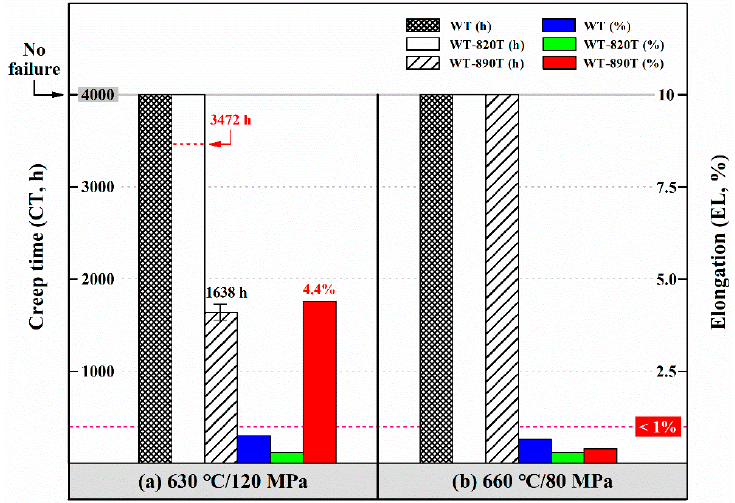
Figure 6. Short ‐ term creep tests of the WT, WT ‐ 820T, WT ‐ 890T samples at ( a ) 630 °C/120 MPa, ( b ) 660 °C/80 MPa. ( b ) 660 ◦ C/80 MPa.